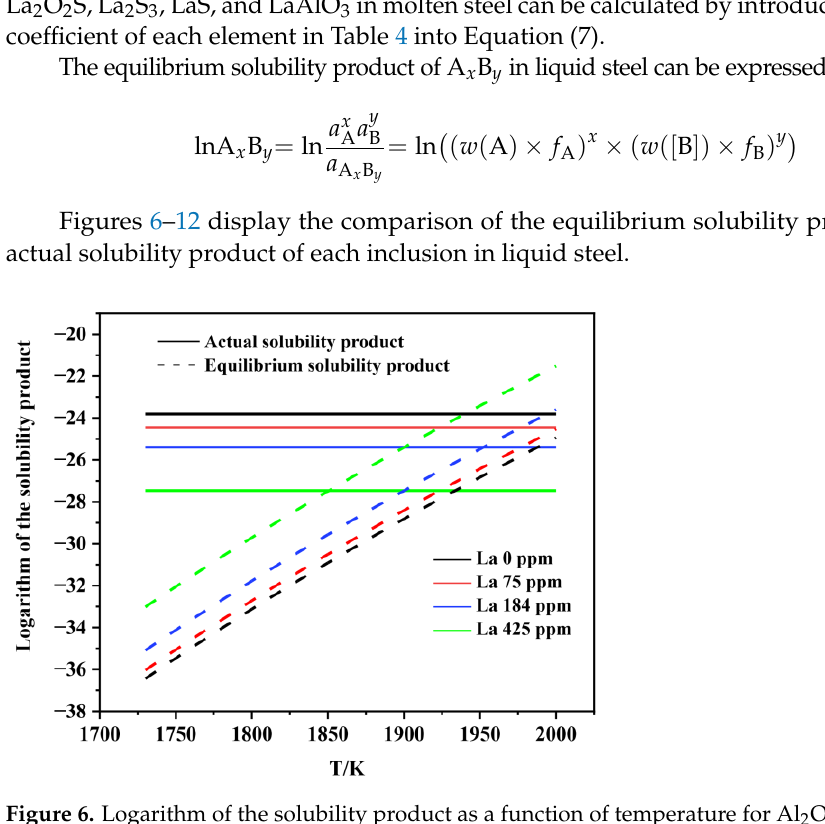
2 O 3 in liquid steel.